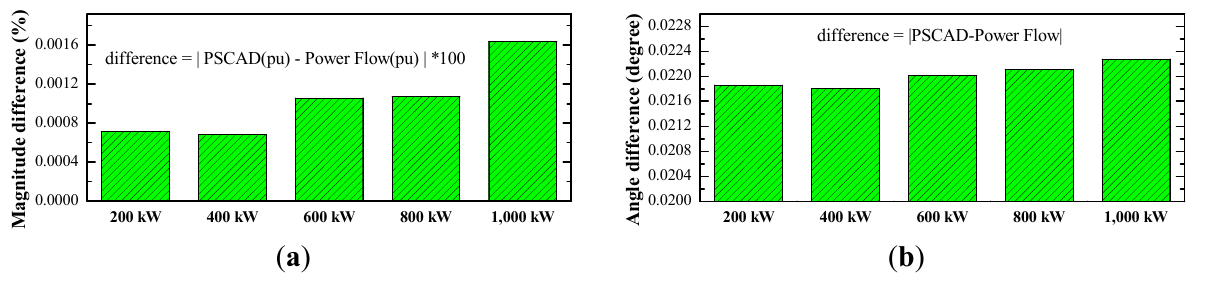
Figure 7. Maximum difference between the power flow results with the proposed DG model and the PSCAD simulation results: ( a ) voltage magnitude and ( b ) voltage angle.